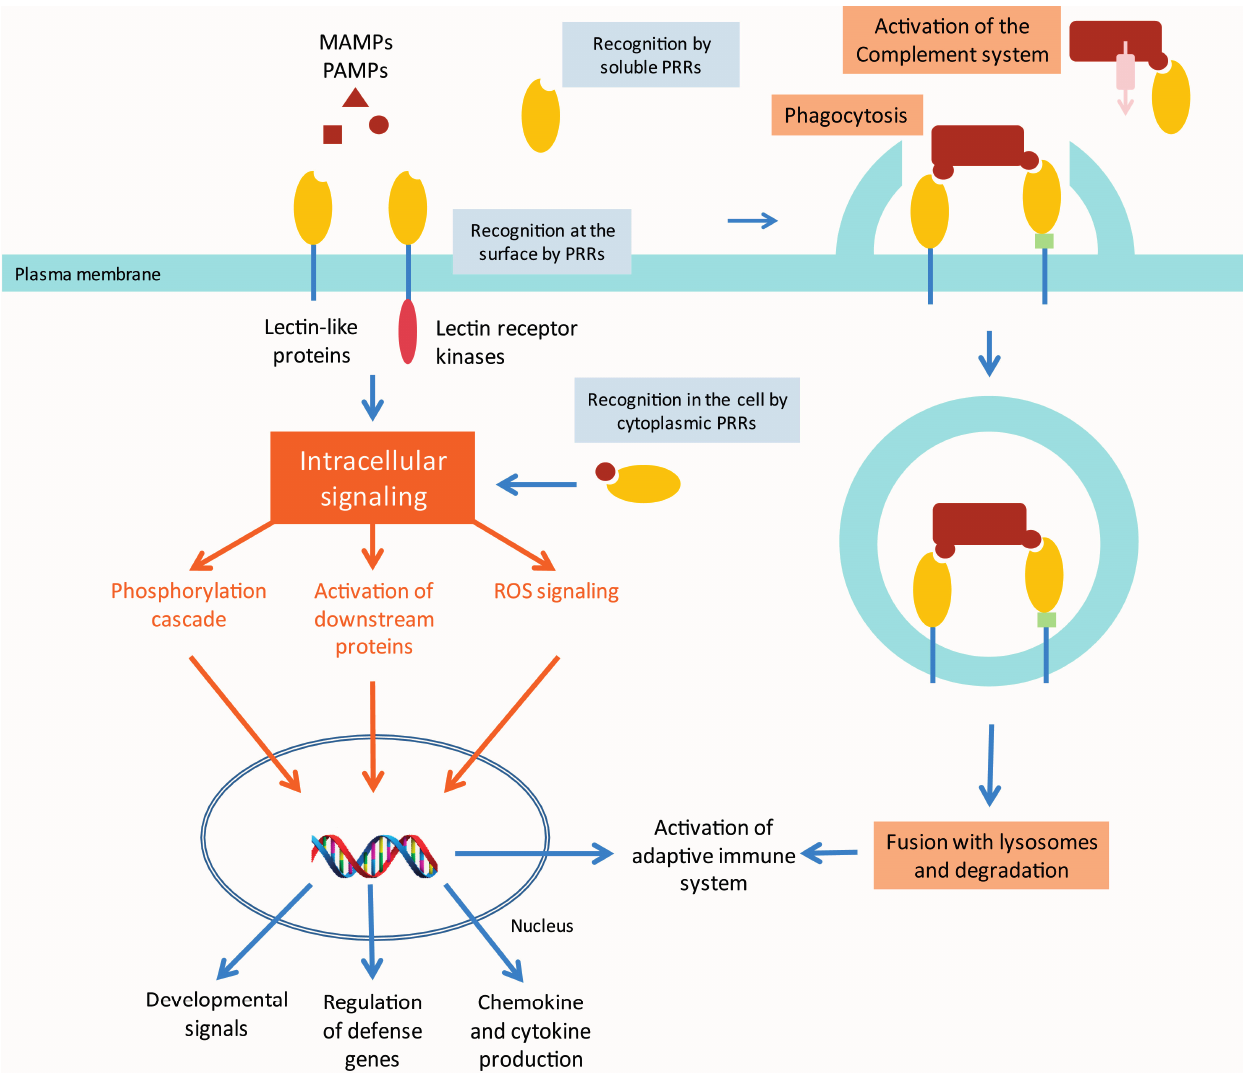
Figure 1. Model of animal innate immunity by lectin PRRs. Detection of pathogen/microbe-associated molecular patterns (P/MAMPs) by membrane bound pattern recognition receptors (PRRs) with lectin domains (lectin receptor kinases and